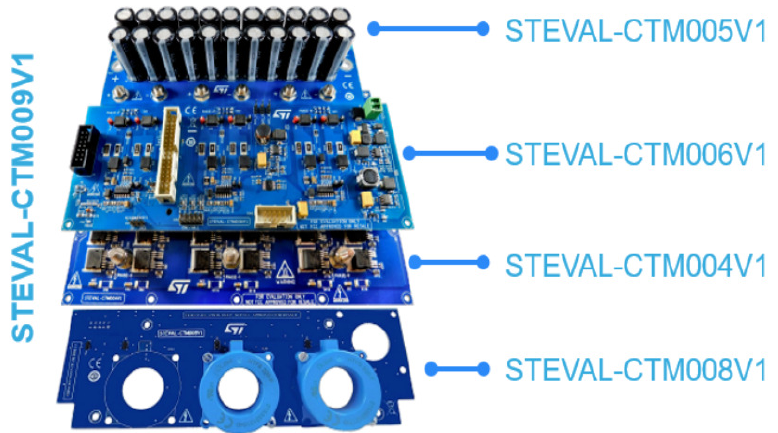
Figure 4. STEVAL-CTM009V1 board